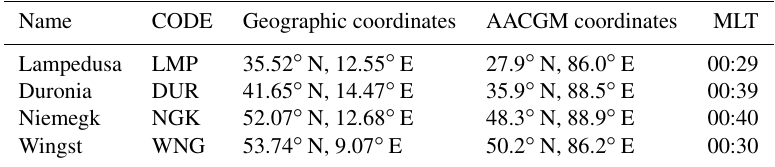
Table 1. Geomagnetic observatories used in this study, geographic coordinates, altitude-adjusted corrected geomagnetic (AACGM) coordi- nates estimated by using the Shepherd (2014) algorithm at 100km above the observatory, and magnetic local time at